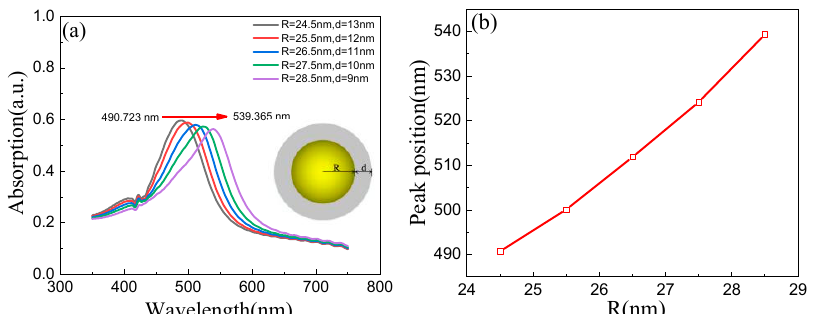
Figure 2. Simulation results for a single Au-Ag NP with R = 24.5–28.5 nm and d = 9–13 nm. ( a ) Absorption spectra of a single Au-Ag NP; inset image: schematic diagram of Au-Ag NPs. ( b ) Plot of peak position versus Au core radius.